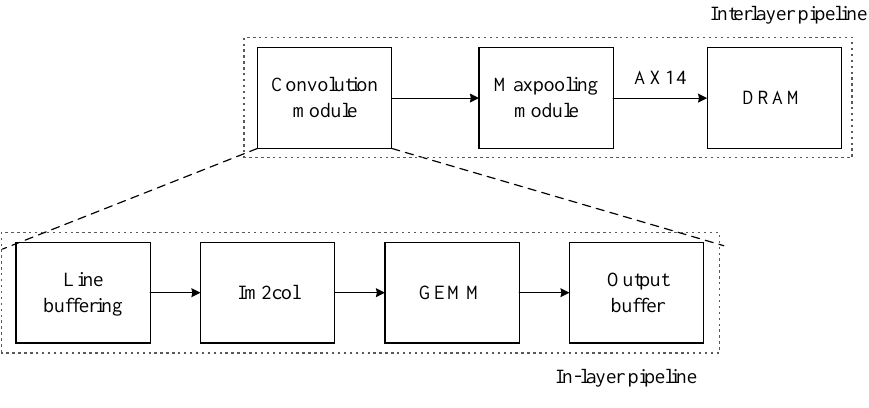
Figure 9. Pipeline